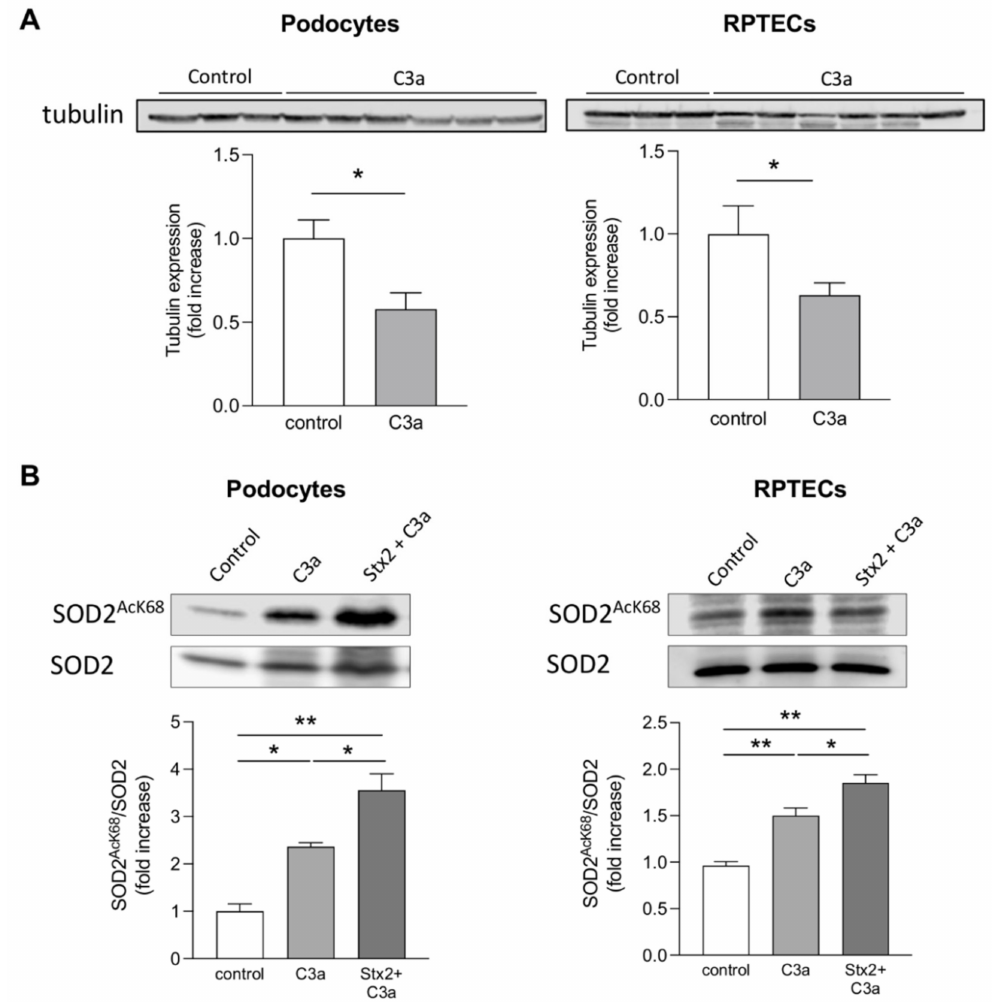
Figure 7. C3a decreases tubulin expression and reduces mitochondrial antioxidant defense in cultured podocytes and RPTECs. Representative western blot and densitometric analysis of ( A ) tubulin and ( B ) acetylated SOD2 (SOD2 AcK68 ) and total SOD2 protein expression in protein extracts obtained from podocytes and RPTECs incubated with control medium, C3a (1 µ M, 6h) alone, or with Stx2 (50 pM, 24 h) in the presence of C3a, added in the last 6 h. SOD2 acetylation was expressed as the ratio between SOD2 AcK68 and total SOD2. Results are presented as mean ± SEM (number of biological samples for tubulin: n = 3 control and n = 6 C3a-treated podocytes; n = 6 control and n = 12 C3a- treated RPTECs), (number of biological samples for SOD2: n = 3 control, C3a and Stx2+C3a-treated podocytes and RPTECs), and unpaired Student’s t test or ANOVA with Tukey multiple-comparisons test were used. * p < 0.05, ** p <